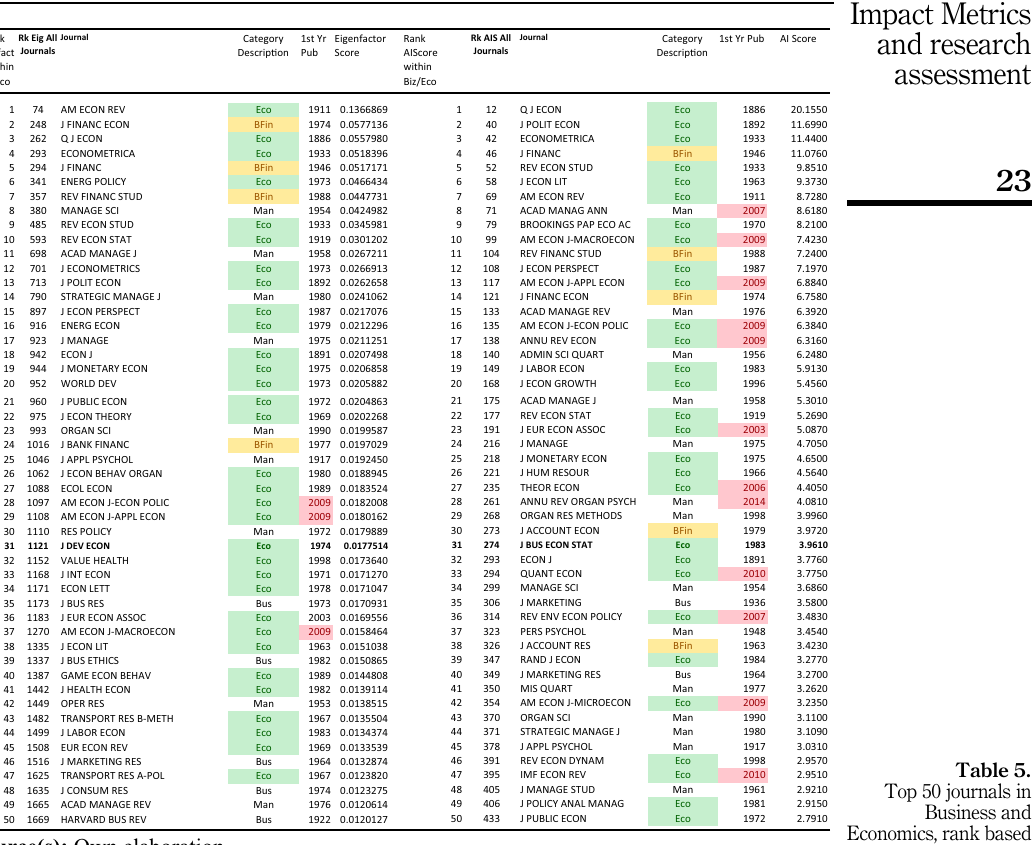
Table 5. Top 50 journals in Business and Economics, rank based on eigenfactor